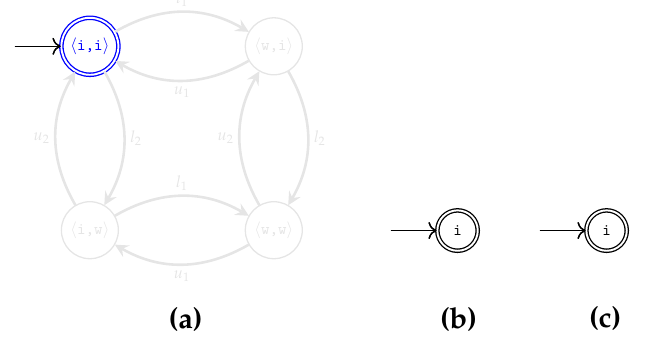
Figure 7. MPL– Initialization Figure 7. MPL—Initialization. ( a ) Explorer; ( b ) R1; ( c ) R2.